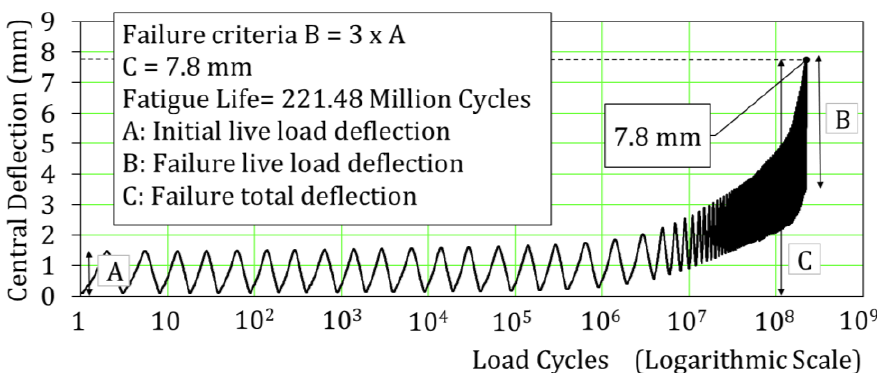
Figure 7. Load cycles versus central total deflection for the referential RC deck.